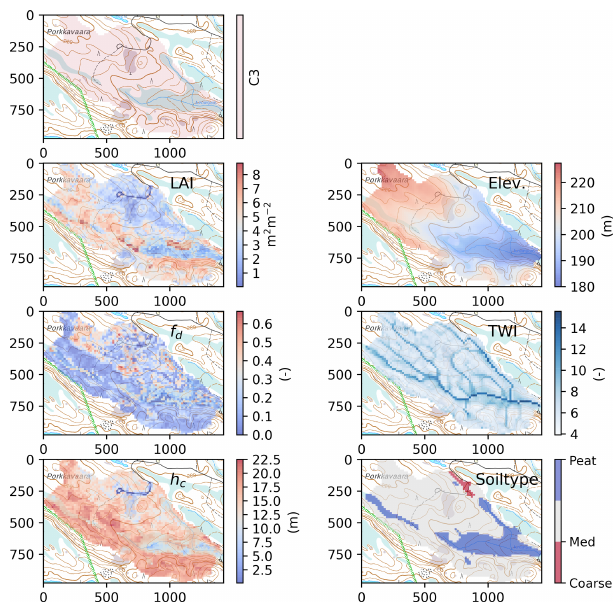
Figure 3. Spatial data at 16m resolution used to set up the model for the catchment C3 Porkkavaara in eastern Finland (see Table S2). LAI: total one-sided leaf-area index; f d : deciduous fraction; h c : canopy height; Elev: elevation; TWI: topographic wetness index; soiltype refers to Table S2. Rasters overlay topographic basemap provided by National Survey of Finland and the scale of x and y axis is